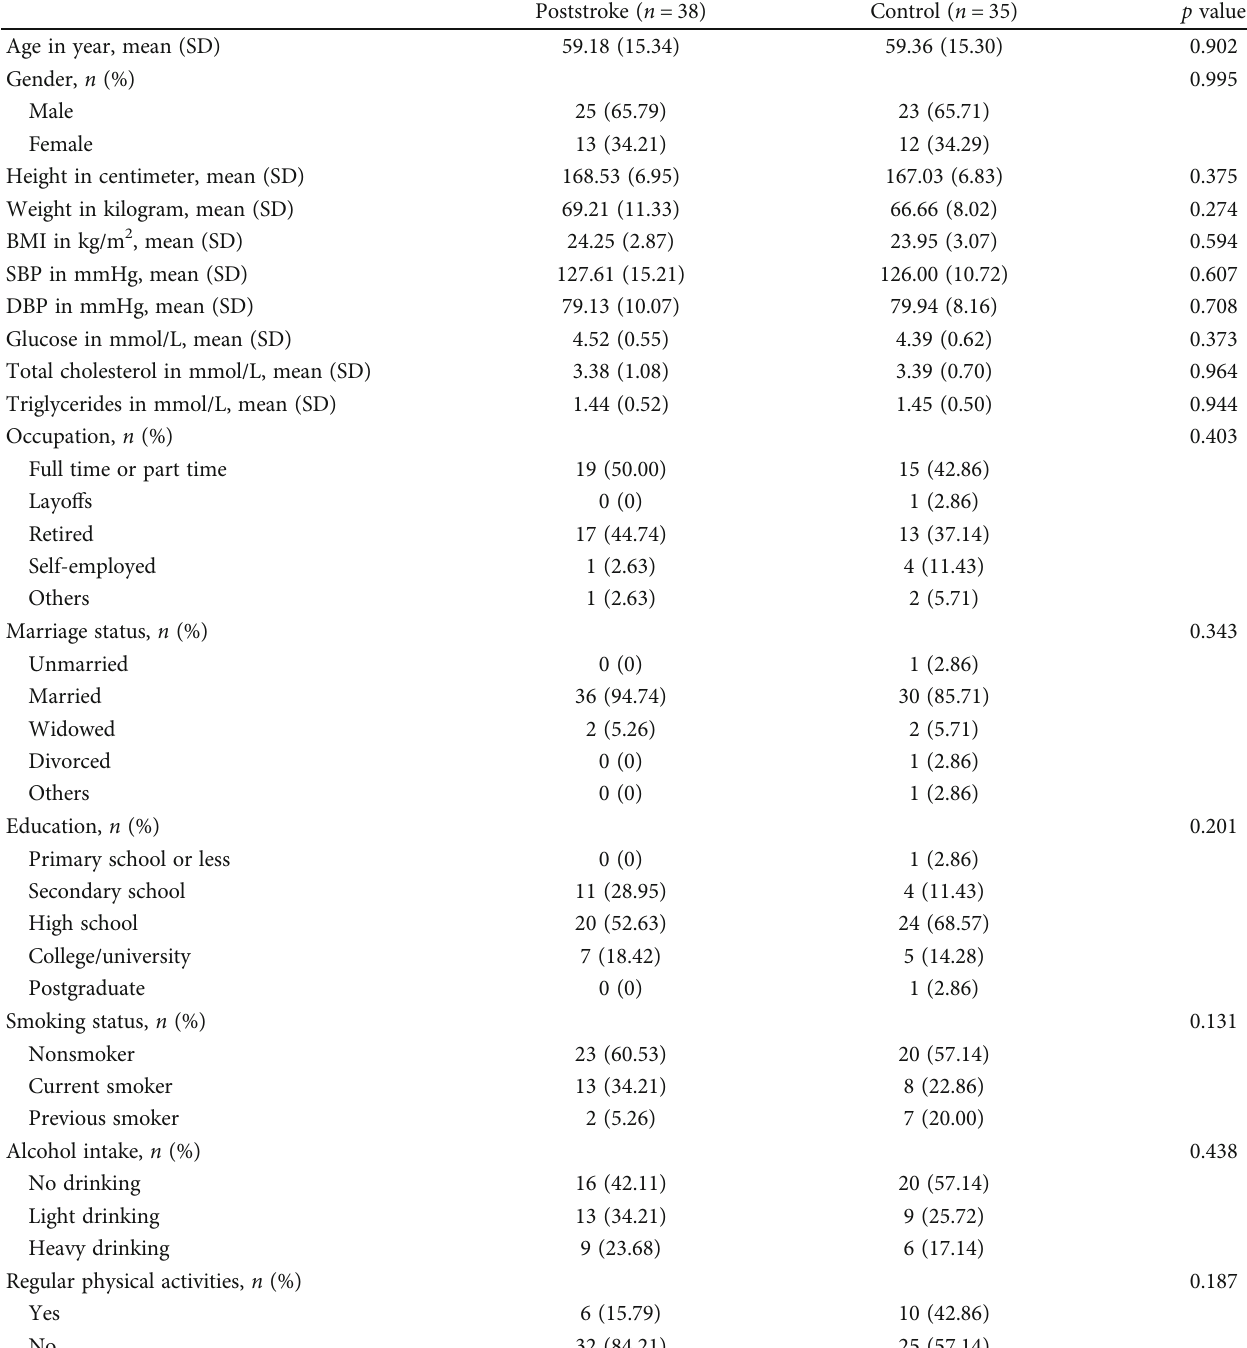
Table 1: Summary of demographic and clinical